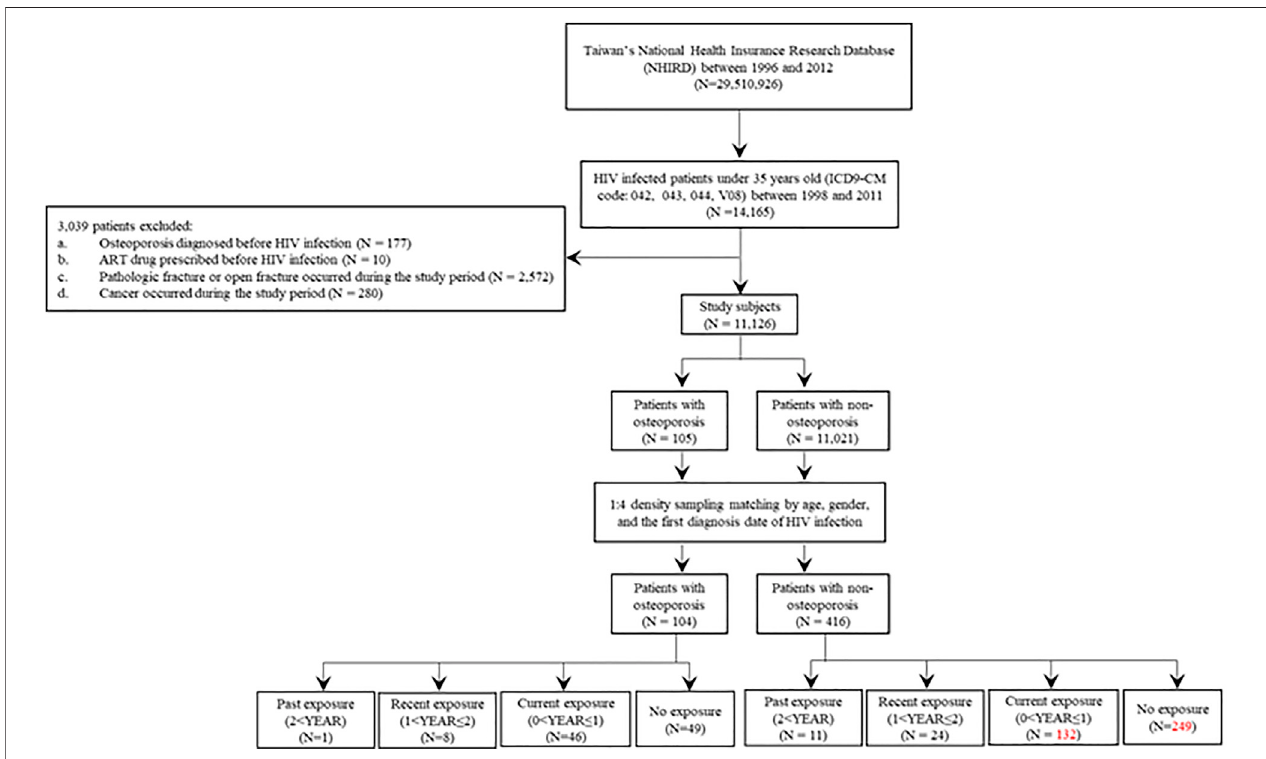
FIGURE 1 | Flow chart for recruitment of osteoporosis cases and non-osteoporosis controls among patients with HIV infection. HIV, human immunode fi ciency virus.